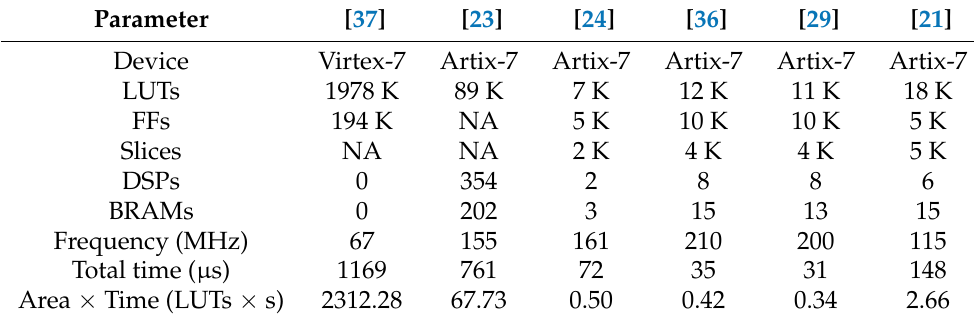
Table 5. Comparison of the existing Kyber-512 hardware